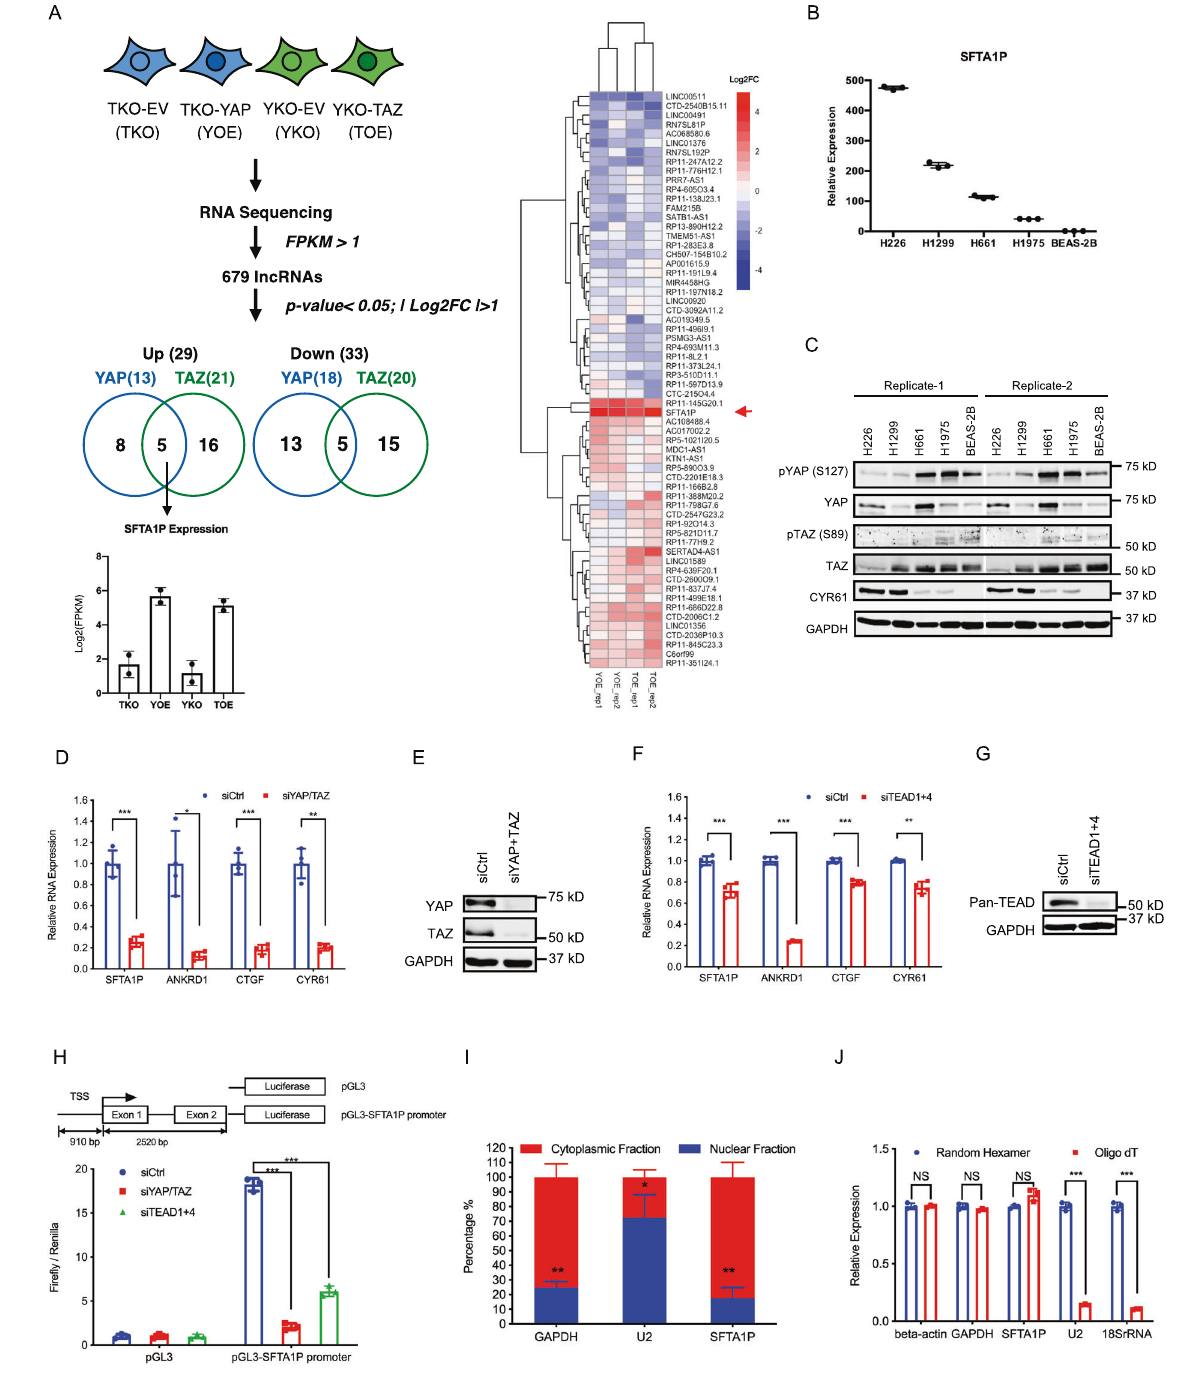
and monitored for tumor growth. Compared to shCtrl-treated cells, which generated large tumors, shSFTA1P-treated cells resulted in either markedly reduced or no tumor formation (Fig. 2F, G). In line with the observations, knockdown of SFTA1P led to a concomitant reduction in the expression of survivin (Fig. 2H), a known inhibitor of apoptosis (IAP), and caspase-3/7 activity [39, 40], further corroborating the anti-apoptotic function of SFTA1P. Altogether, our in vitro and in vivo data suggest that SFTA1P may play a pro-proliferative and anti-apoptotic role in NSCLC